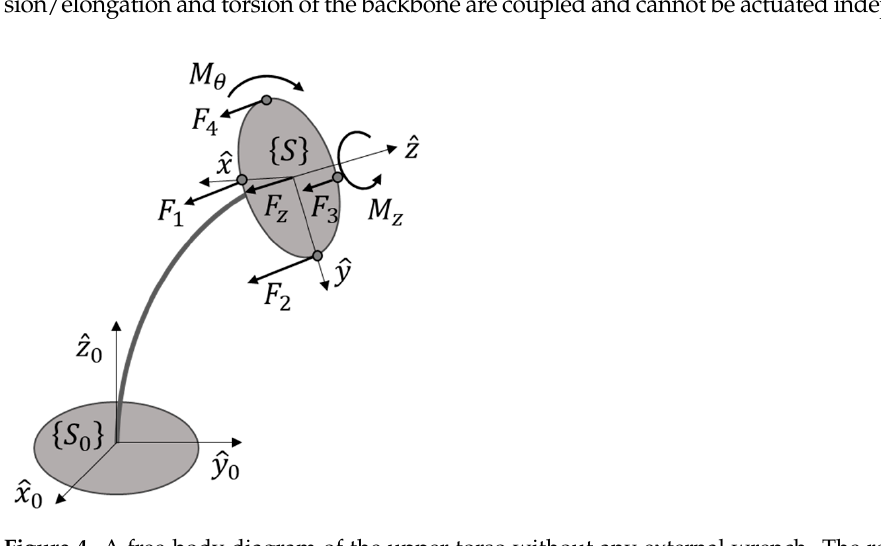
Figure 4. A free-body diagram of the upper torso without any external wrench. The reactions of the backbone are represented by 𝑀 (cid:3053) , 𝐹 (cid:3053) , and 𝑀 (cid:3087) , whereas 𝐹 (cid:2869) , 𝐹 (cid:2870) , 𝐹 (cid:2871) , and 𝐹 (cid:2872) are the tensions in the backbone are represented by M z , F z , and M θ , whereas F 1 , F 2 , F 3 , and F 4 are the tensions in the the actuation tendons. actuation